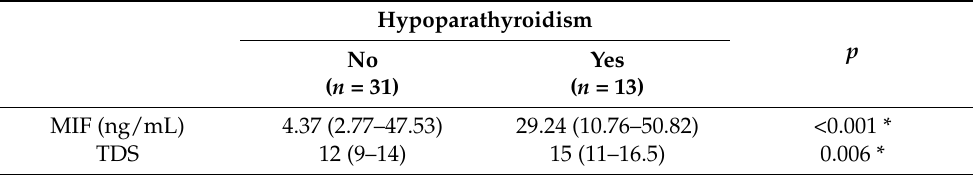
Table 4. Correlation between postoperative hypoparathyroidism and MIF or TDS.